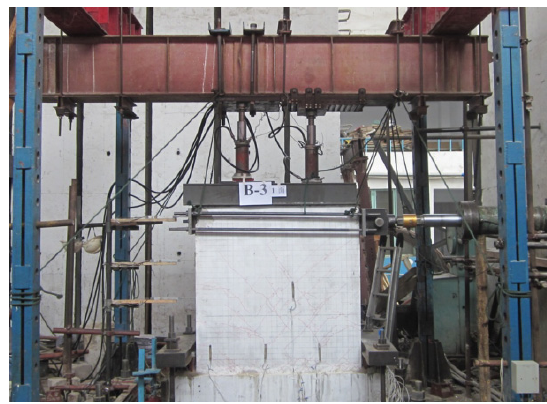
Figure 8. Onsite experimental loading